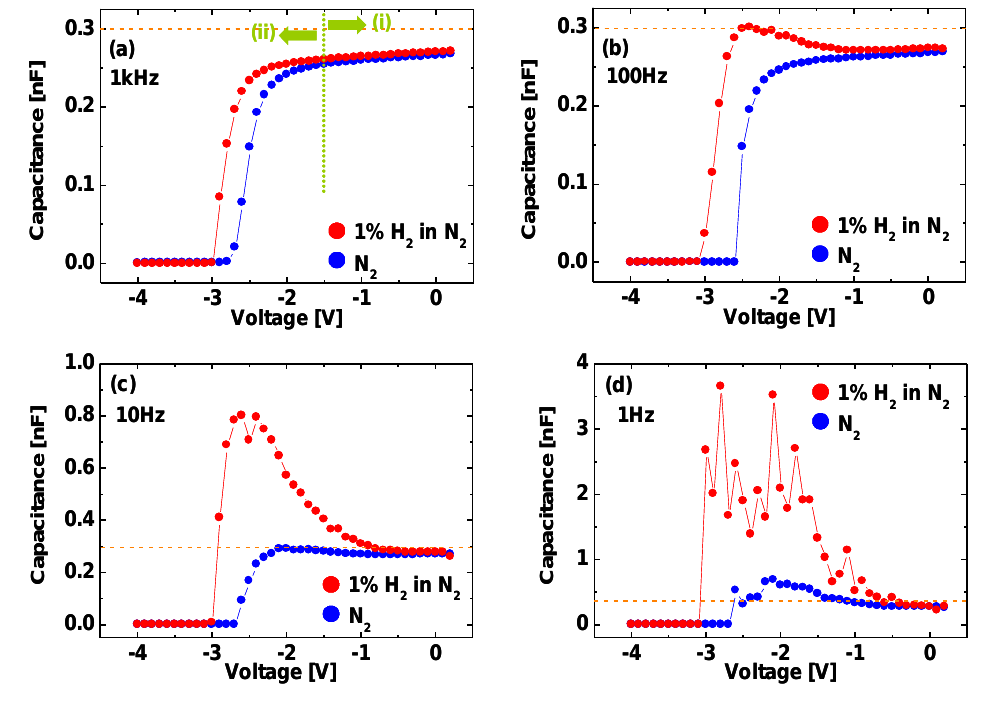
and response to exposure to 100 ppm H 2